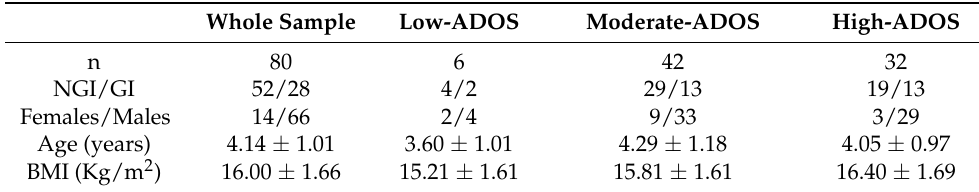
Table 4. Characteristics of the subjects in the whole sample and in the three severity subgroups. Whole Sample